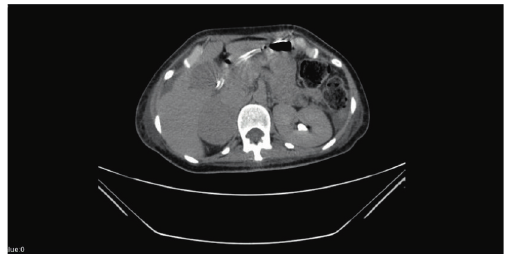
Figure 1: Abdominal CT scan of the patient shows heterogeneous right adrenal